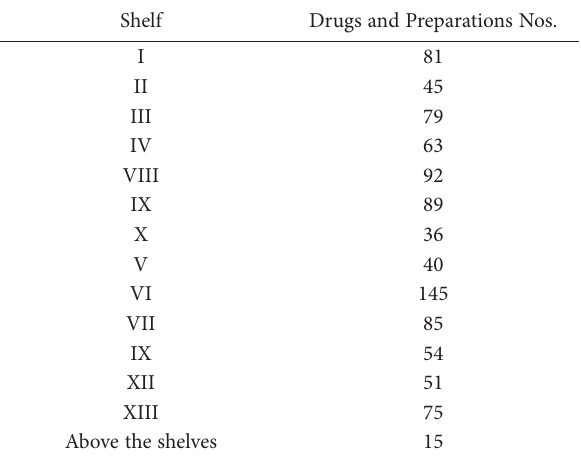
Table 2. Numbers of shelves and preparations as listed in Index